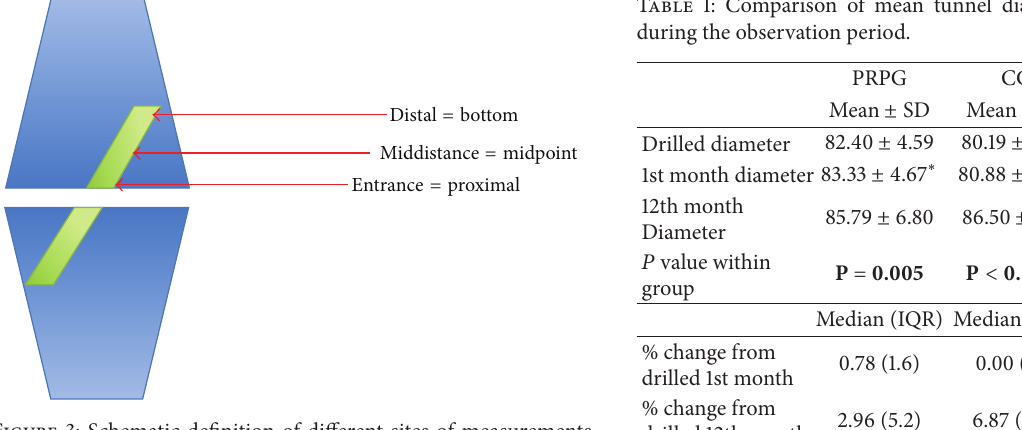
Figure 3: Schematic definition of different sites of measurements within the femoral tunnelin this study.